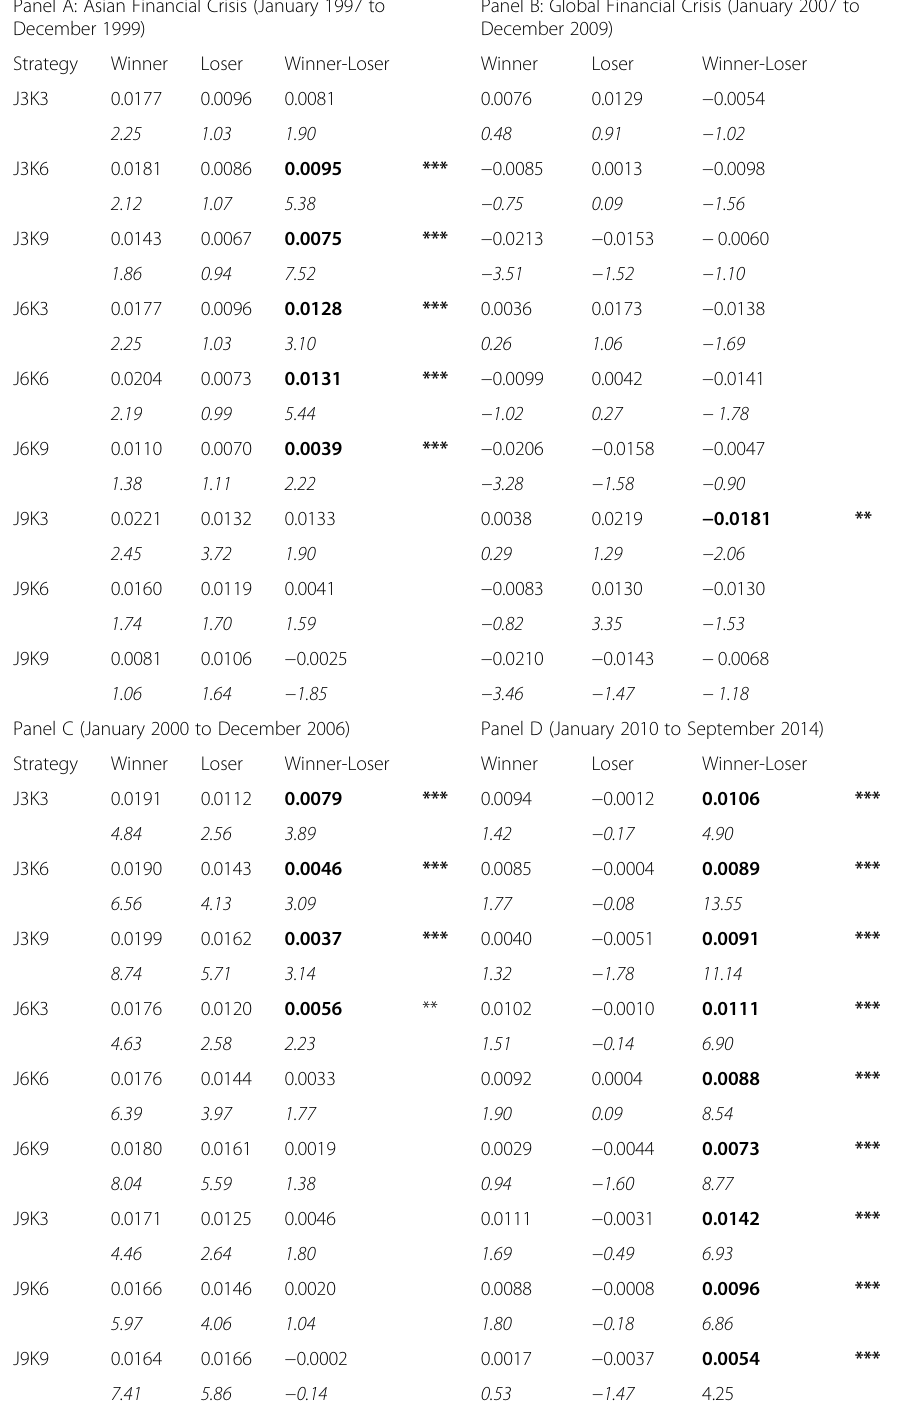
Table 8 Momentum Returns Across Different Time